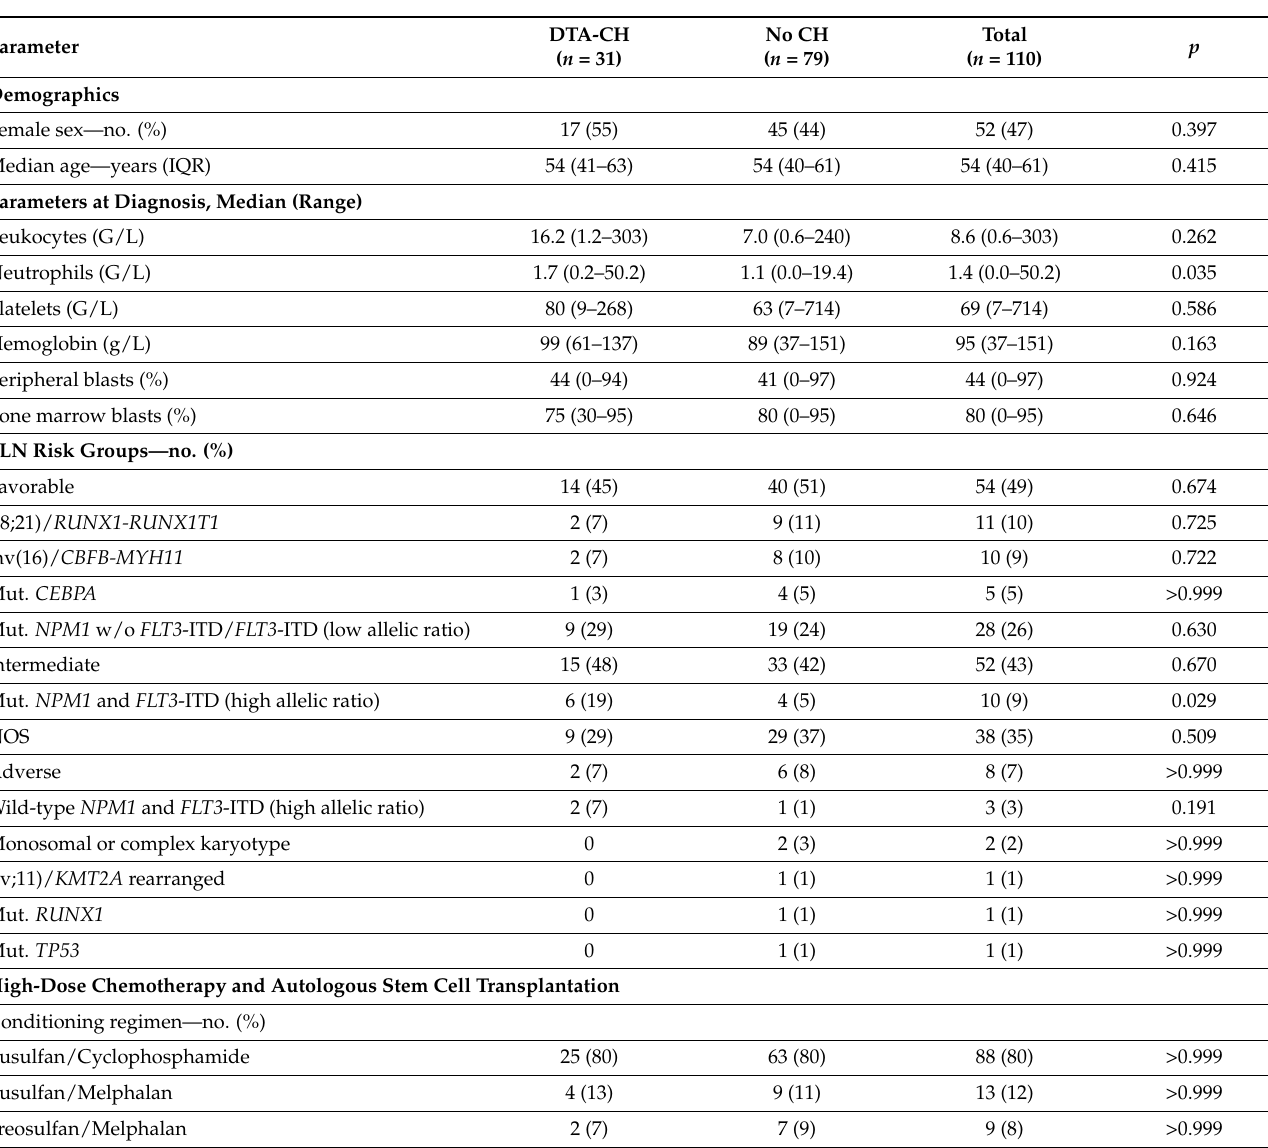
Table 1. Baseline characteristics for patients included in the study. The p values are for differences between the DTA-CH (clonal hematopoiesis) and no CH groups. IQR: interquartile range; NOS: not otherwise specified; Mut: mutated; w/o: without; ASCT: autologous hematopoietic stem cell transplantation; BW: body weight. FLT3-ITD allelic ratios were <0.5 (low) and ≥ 0.5